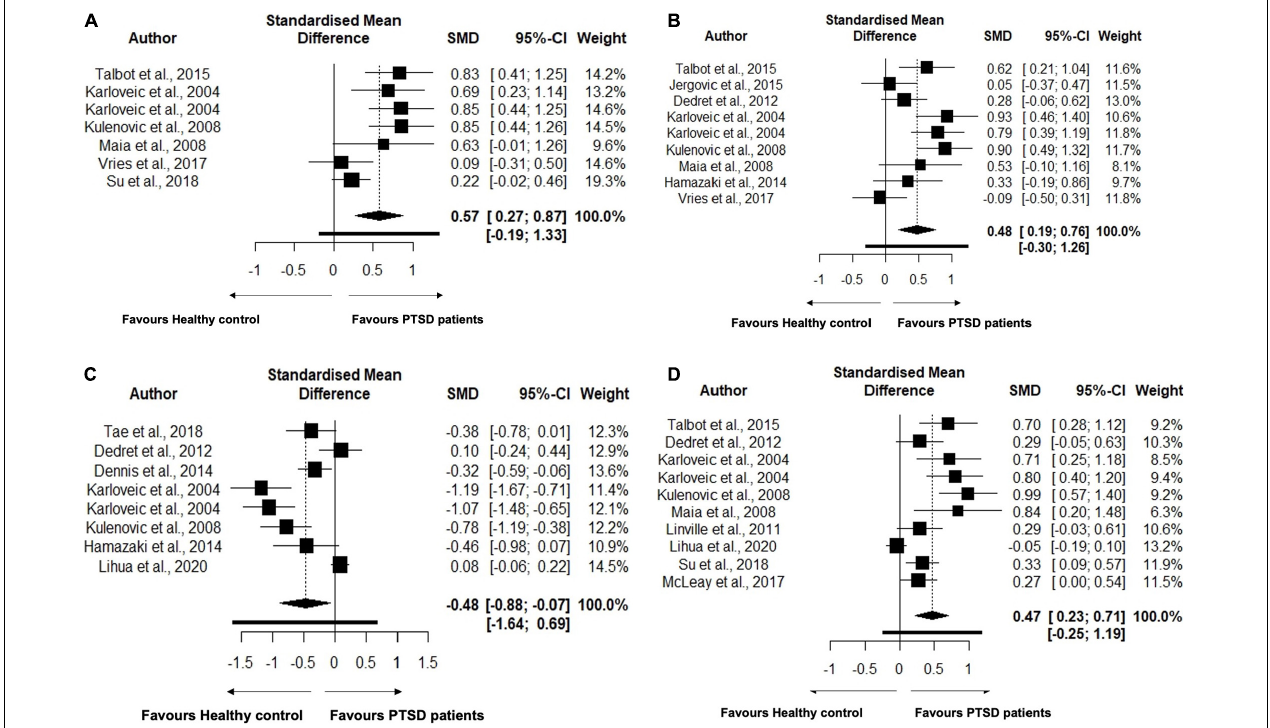
FIGURE 2 | (A) Forest plot showing lipid parameter Total Cholesterol (TC) levels in the patients with Post-traumatic Stress Disorder (PTSD) and healthy controls. The black squares correspond to the standardized mean difference (SMD) of each study and horizontal bars represent 95% Cl of each study. (B) Forest plot showing lipid parameter Low Density-Lipoprotein (LDL) levels in the patients with Post-traumatic Stress Disorder (PTSD) and healthy controls. The black squares correspond to the standardized mean difference (SMD) of each study and horizontal bars represent 95% Cl of each study. (C) Forest plot showing lipid parameter High Density-Lipoprotein (HDL) levels in the patients with Post-traumatic Stress Disorder (PTSD) and healthy controls. The black squares correspond to the standardized mean difference (SMD) of each study and horizontal bars represent 95% Cl of each study. (D) Forest plot showing lipid parameter Triglyceride (TG) levels in the patients with Post-traumatic Stress Disorder (PTSD) and healthy controls. The black squares correspond to the standardized mean difference (SMD) of each study and horizontal bars represent 95% Cl of each